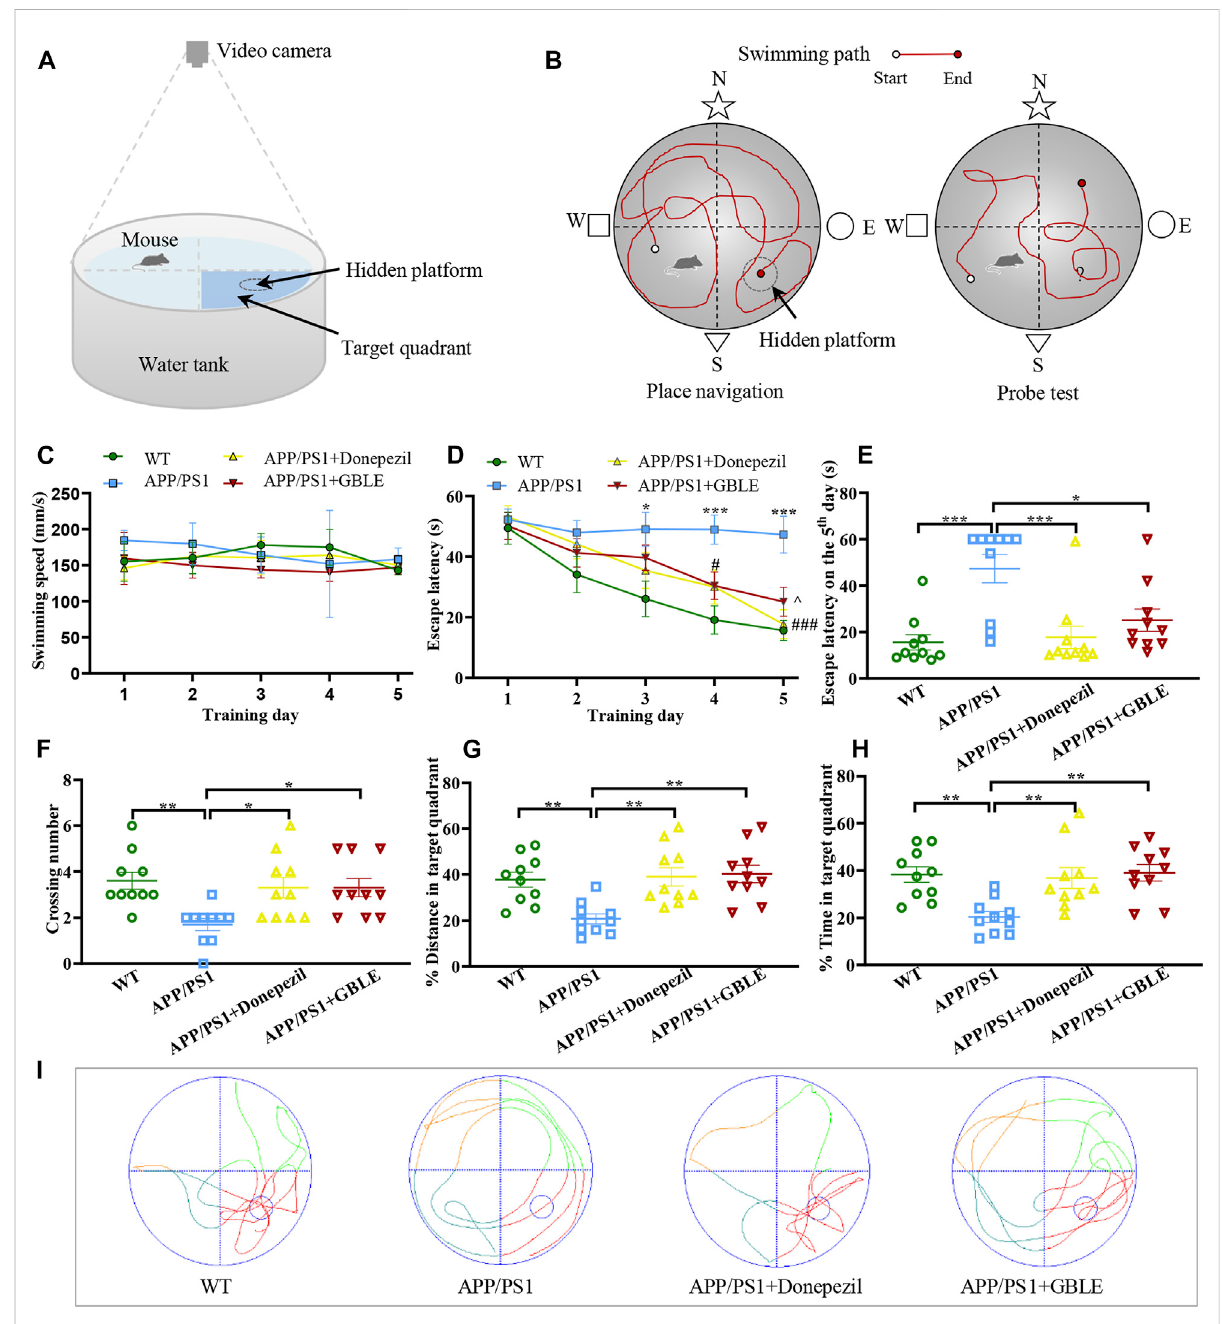
The performance of mice in Morris water maze (MWM) test. (A) Schematic diagram of MWM equipment. (B) Illustration of place navigation test and probe testin MWM. (C) The swimming speeds of mice in differentgroups during fi ve consecutive training days. (D) The escape latencies of mice in different groups during fi ve consecutive training days. *: p < 0.05, ***: p < 0.001 for APP/PS1 group versus WT group; # : p < 0.05, ### : p < 0.001 for APP/PS1+Donepezilgroup versus APP/PS1group; ^ : p < 0.05forAPP/PS1+GBLEgroup versus APP/PS1group. (E) Theescapelatenciesofmicein different groups on the 5th day. (F) The average crossing number over the platform during the probe test. (G) The percentage of distance in target quadrantduringtheprobetest. (H) Thepercentageoftimespentintargetquadrantduringtheprobetest.Datawerepresentedasmean±SEM.*: p < 0.05, **: p < 0.01, ***: p < 0.001. (I) Representative swimming paths of mice in the four groups during the probe